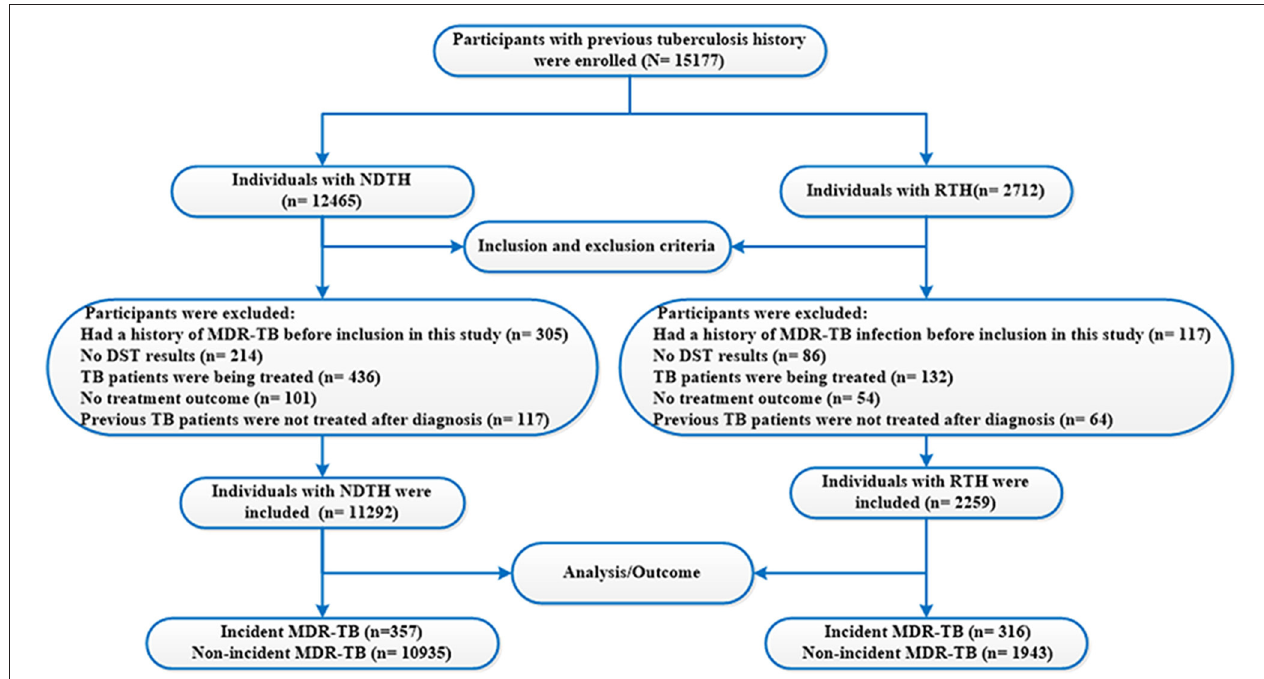
FIGURE 1 | Flow chart of the study population. TB, tuberculosis; MDR-TB, multidrug-resistant tuberculosis; NDTH, newly diagnosed tuberculosis history; RTH, retreated tuberculosis history; DST, drug susceptibility testing.